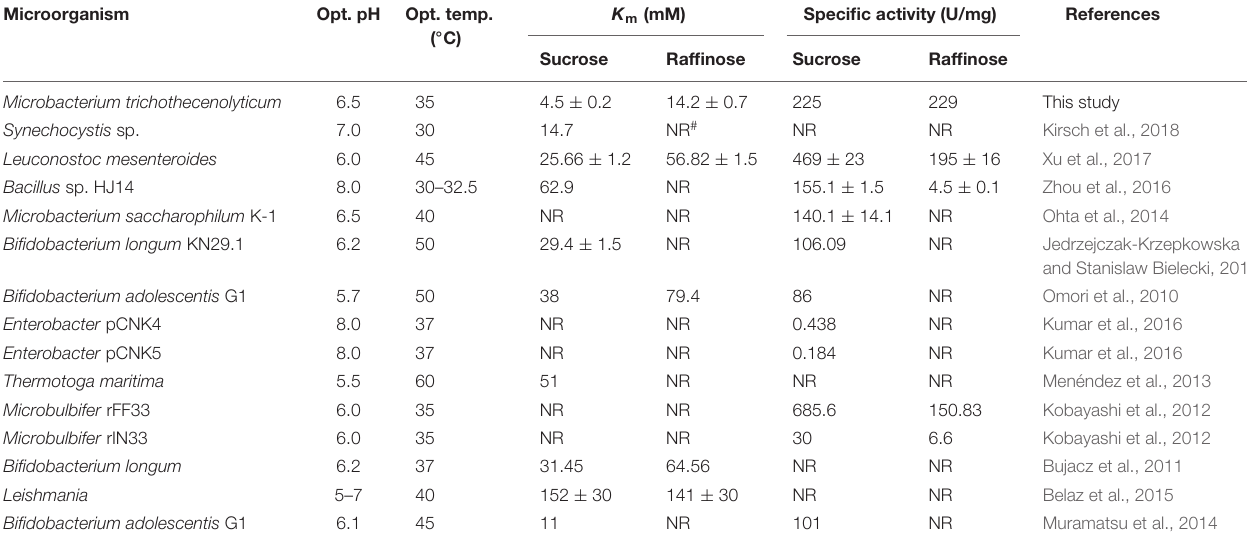
TABLE 1 | Comparison of biochemical properties of InvDz13 with other bacterial invertases. Microorganism Opt. pH Opt. temp.